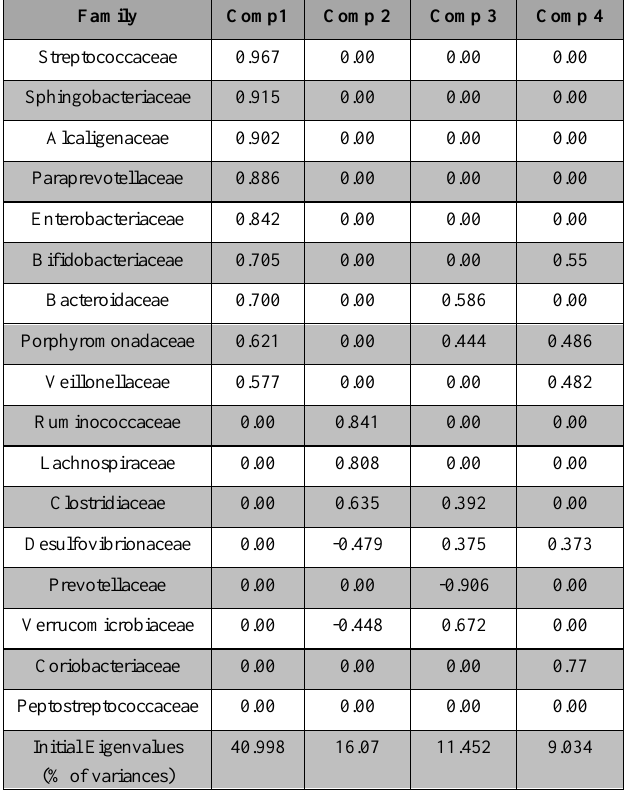
Table 1a. A rotated component matrix for family among T2DM subjects.